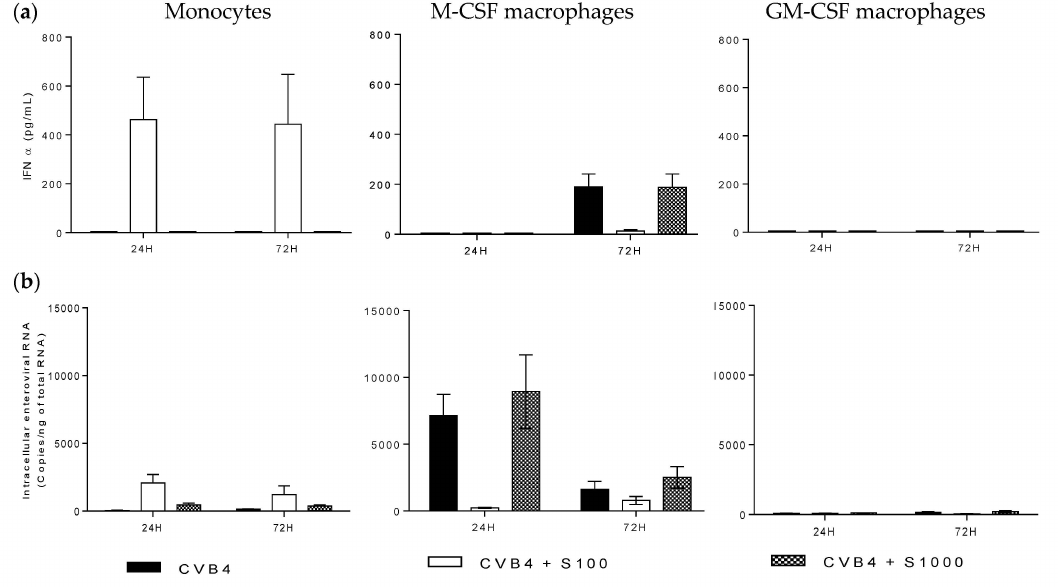
Figure 2. Group B coxsackieviruses 4 (CVB4) can infect M-CSF-induced monocyte-derived macrophages. Monocytes and monocytes treated with M-CSF or GM-CSF for seven days (M-CSF macrophages and GM-CSF macrophages) were inoculated with CVB4 or CVB4 mixed with diluted anti-CVB4 human serum (S100: 1/100 dilution, S1000: 1/1000 dilution). The cell cultures were incubated for 24 h and 72 h, then IFN α levels in the supernatants were measured by using ELISA ( a ), and intracellular viral RNA was quantified by using real-time RT-qPCR ( b ). These results are the mean ˘ SEM of three independent